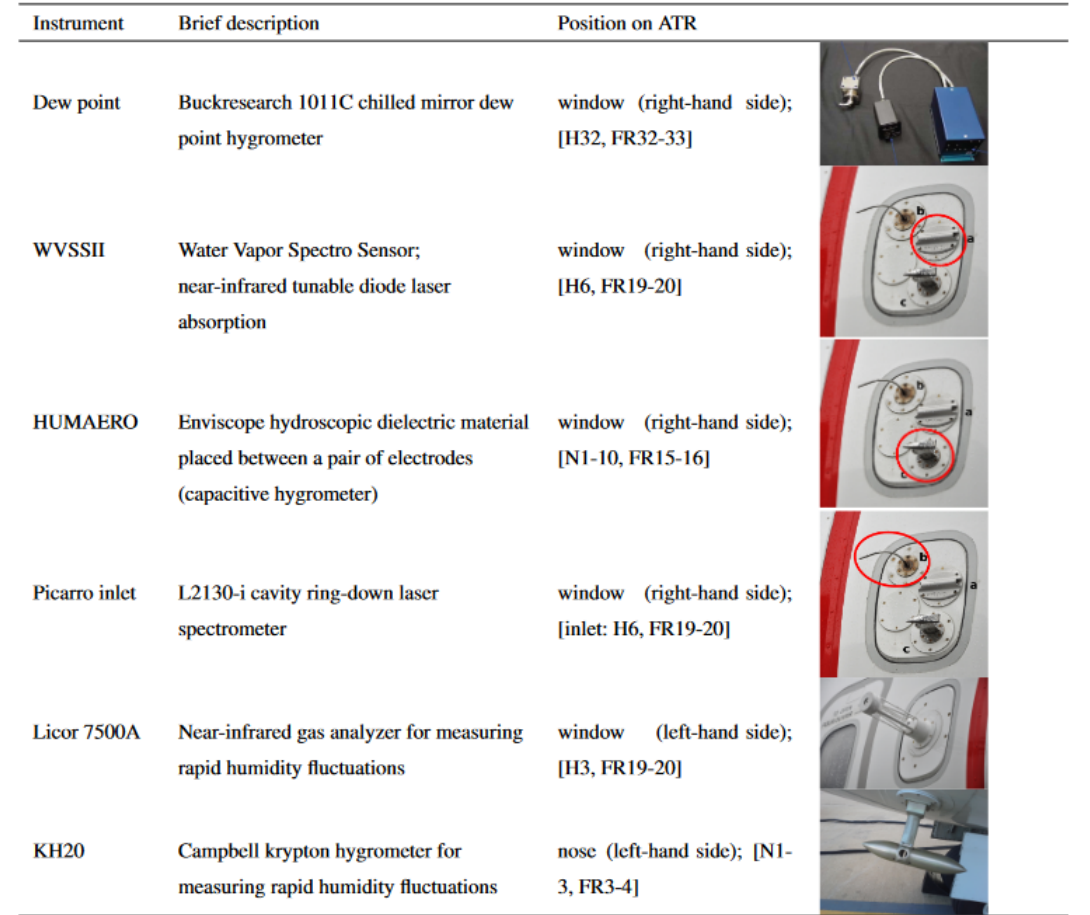
Table 6. Humidity sensors. Note that the cavity ring-down spectrometer (whose inlet is shown here) is represented in Table 9. See Appendix D for the correspondence between the position on the aircraft and the ATR